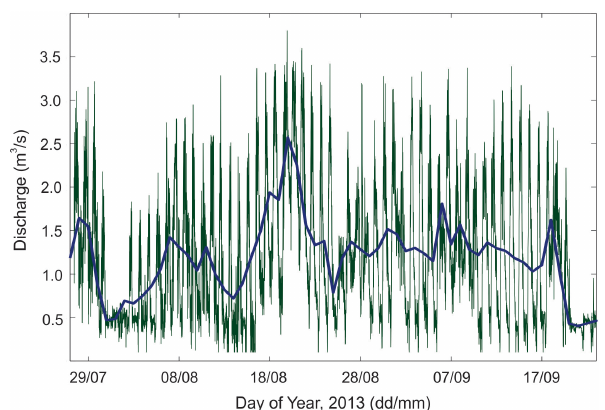
Figure 9. Measured discharge in Haig Stream, 24 July–22 Septem- ber 2013 (m 3 s − 1 ) . The green line indicates 15min data and the heavy blue line is the mean daily discharge.